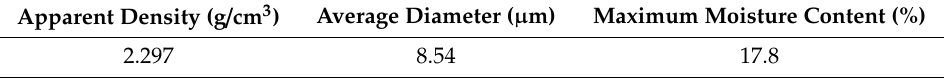
Table 4. Properties of zeolite.